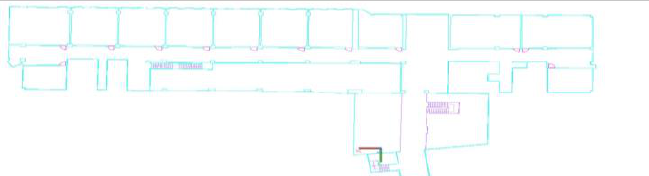
Figure 4/a. SBİF UAV Data . Figure 4/b. Campus Orthophoto.